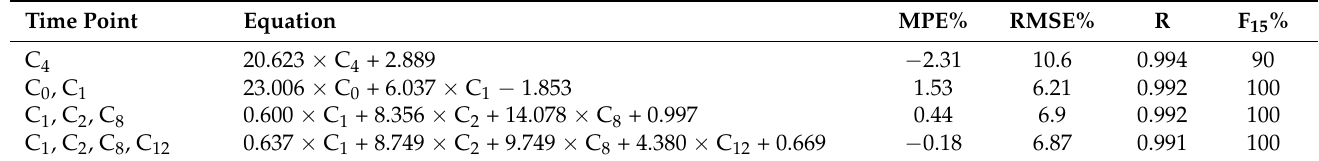
Figure 2. Boxplot of prediction error (PE%) for twelve models from LSSs using validation group in this study. The black solid line and dashed vertical lines represent 0% and ± 15% prediction error, respectively. Green, purple, blue, and red boxes represent LSSs consisting of single, two, three, and four concentration–time points, respectively. * Model with the best predictability within the same number of concentration–time points. Table 2. Predictive performance of the best PMB LSSs developed by MLR analysis from our